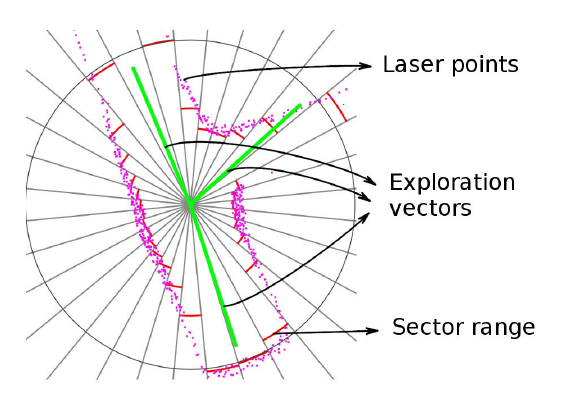
Figure 10. Interpretation of laser scan